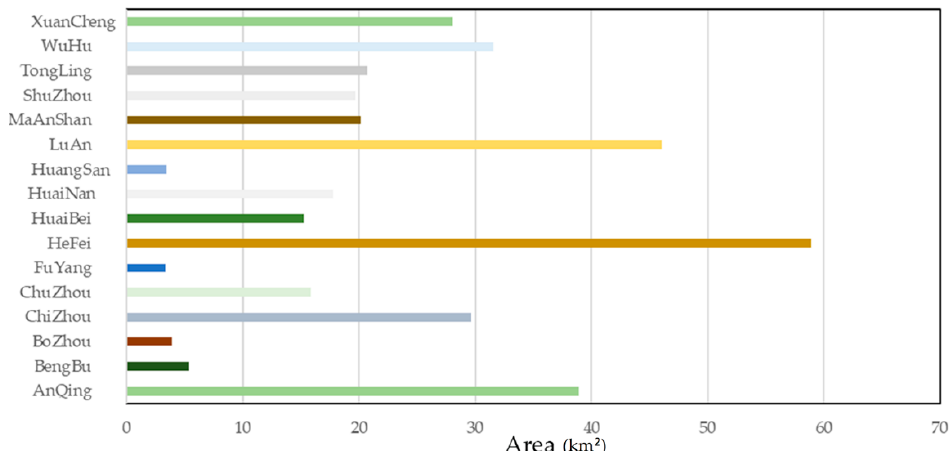
Figure 13. Statistical plot of conflict land area between ecological land protection and urban expansion by region.